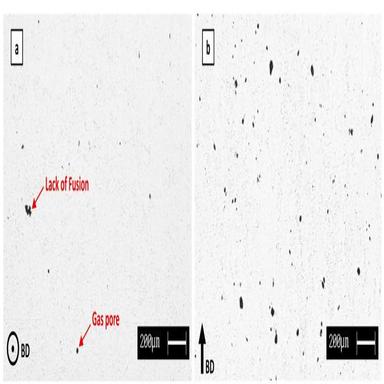
cross sections of layers lying perpendicular (a) and parallel (b) to the Building Direction (BD) of the LPBF process.